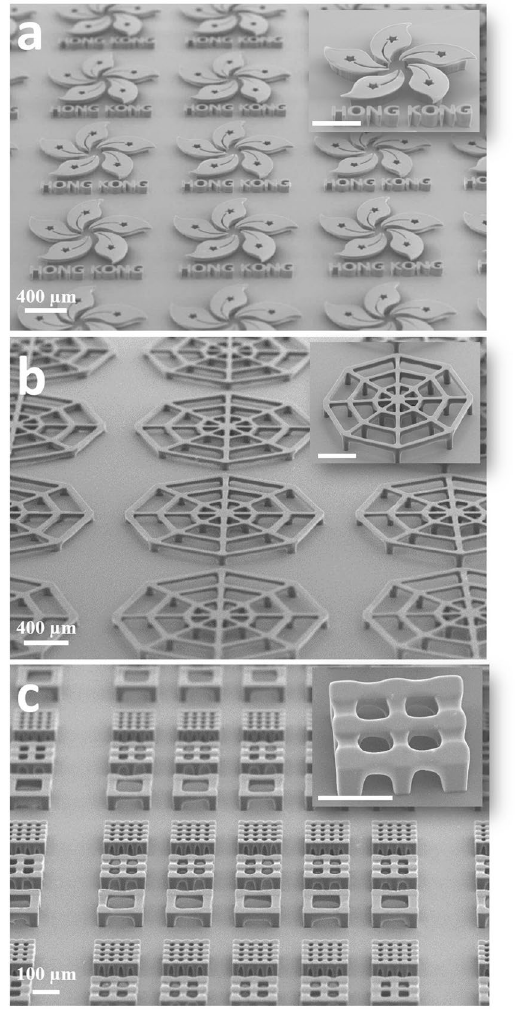
Figure 2. SEM images of the fabricated 3D microstructure arrays: ( a ) Hong Kong Bauhinias, ( b ) uplifted micro-cobwebs, ( c ) 3D cubic